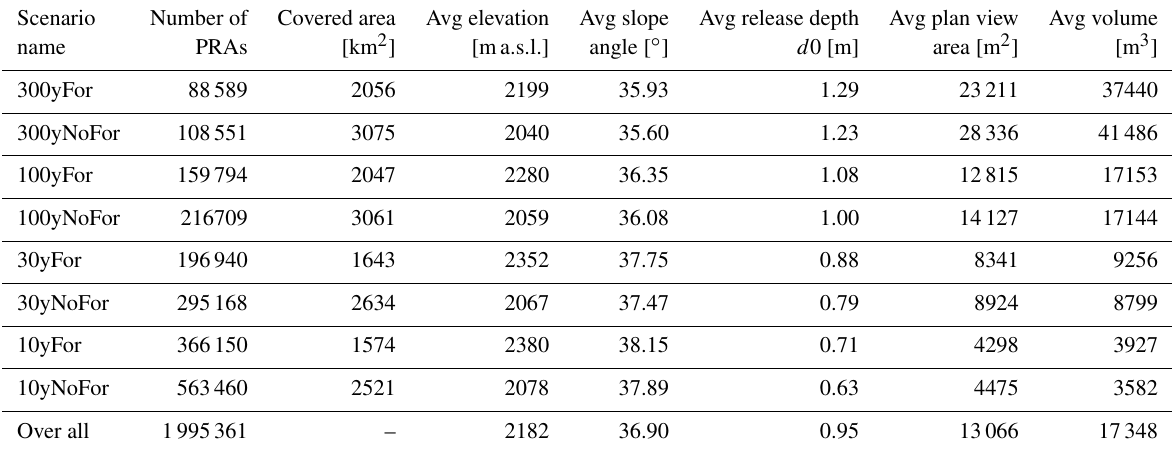
Table 1. Statistical overview of the PRAs for the eight different scenarios over the entire canton of